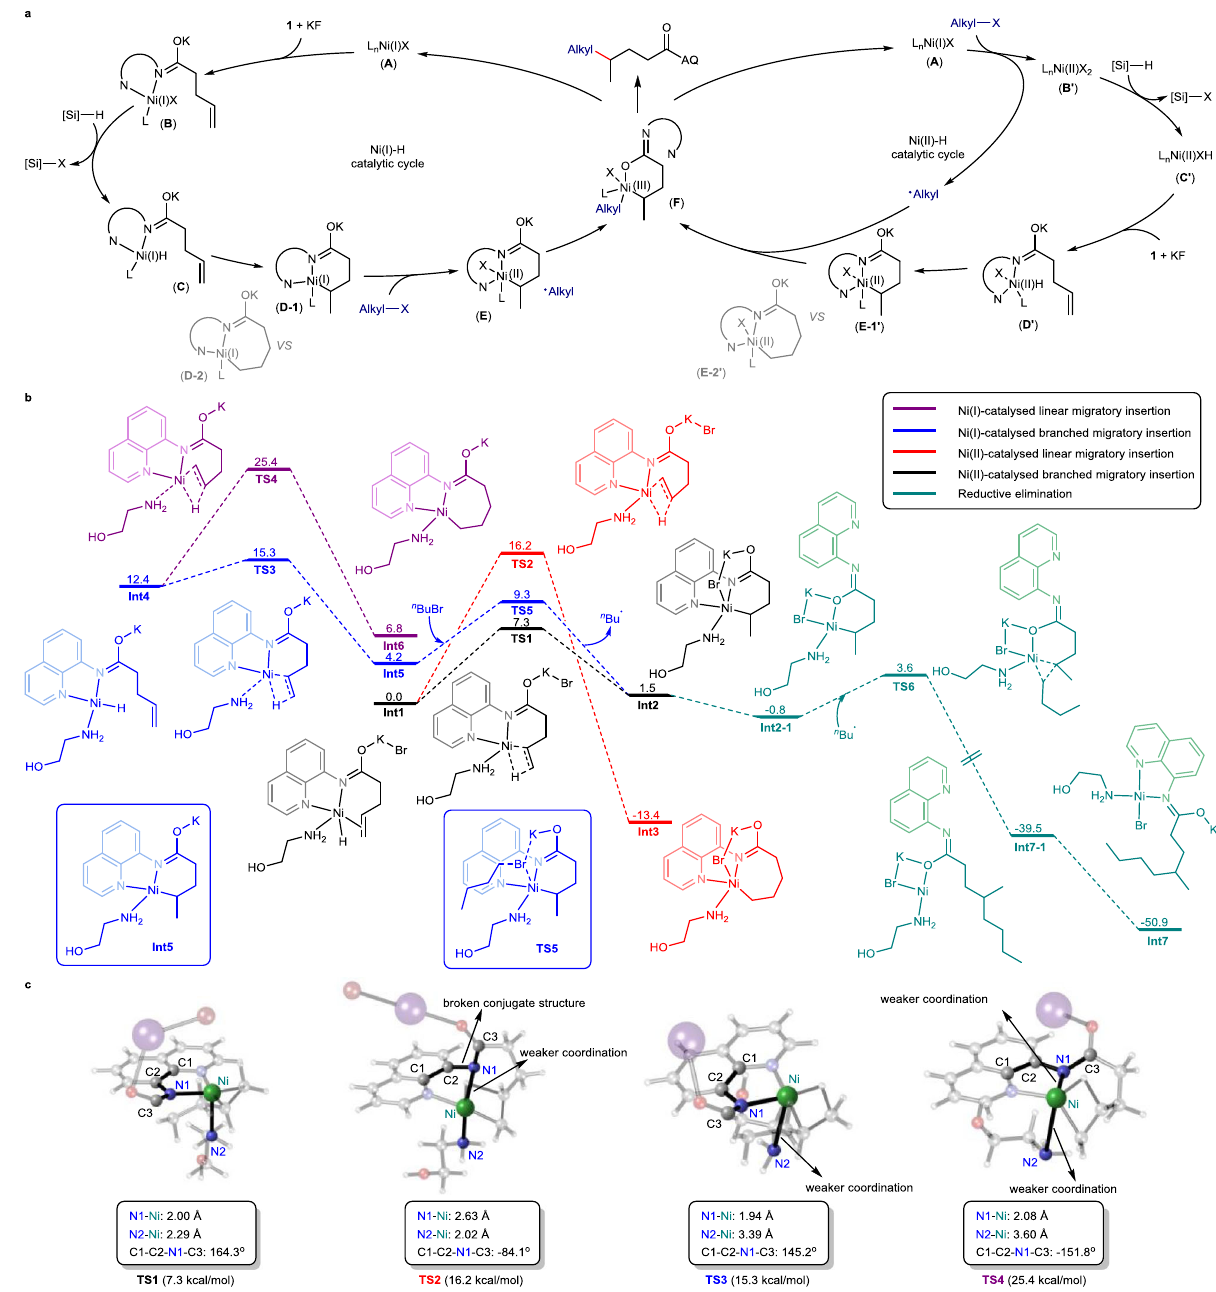
Fig. 5 Proposed mechanism and DFT calculation details. a Proposed mechanism. b DFT calculations at the M06L-D3/6-311 + G(d,p)-SDD- SMD(DMA)//B3LYP-D3/6-31 G(d)-SMD(DMA) level of theory. Free energies are given in kcal/mol. c Optimized 3D structures of TS1 , TS2 , TS3 and TS4